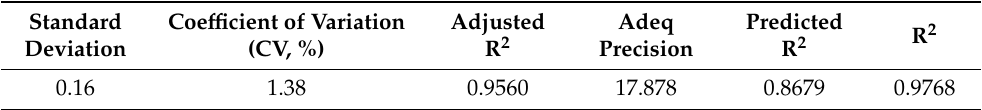
Table 2. Regression coe ffi cients of the predicated second-order polynomial model for the response